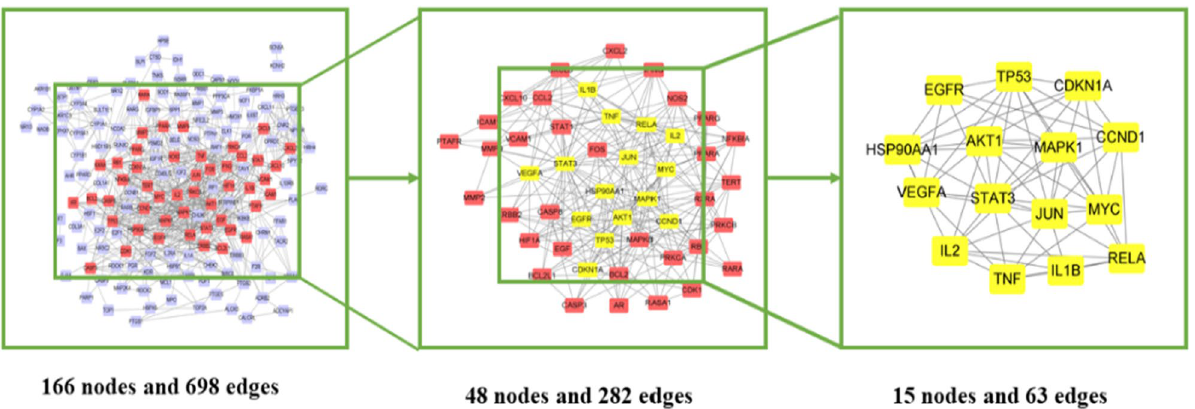
Figure 3. The protein–protein interaction (PPI) network. (A) The PPI network containing 166 nodes and 698 edges. The areas highlighted in red are represented the candidate targets ranked in the median values for the DC, BC, CC, EC, LAC, NC. (B) The PPI network for the candidate targets ranked in the median values for the DC, BC, CC, EC, LAC, NC. The PPI network containing 48 nodes and 282 edges. The areas highlighted in yellow are represented the potential targets with the median values for the DC, BC, CC, EC, LAC, NC. (C) The PPI network for the 15 potential targets with the median values for the DC, BC, CC, EC, LAC,